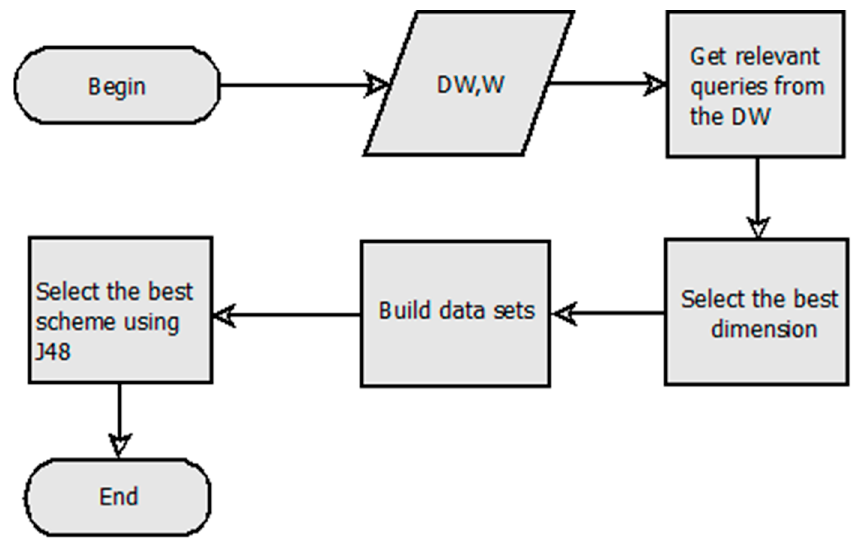
Figure 1. Horizontal fragmentation method for data warehouses based on decision trees. Table 2. Queries executed in SSB.